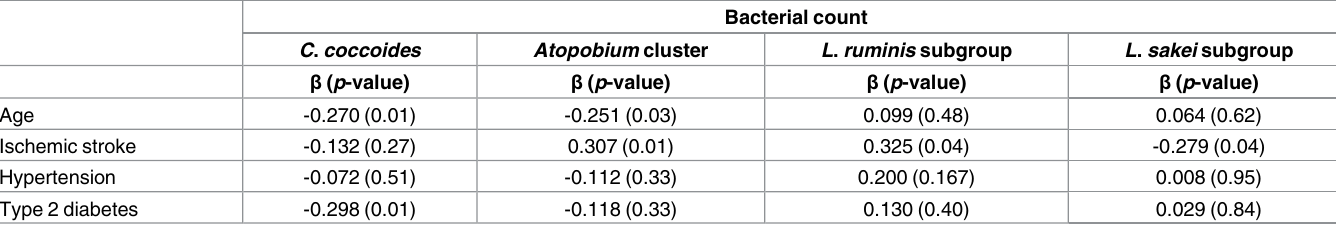
Table 3. Multivariable linear regression analysis to identify contributors to bacterial